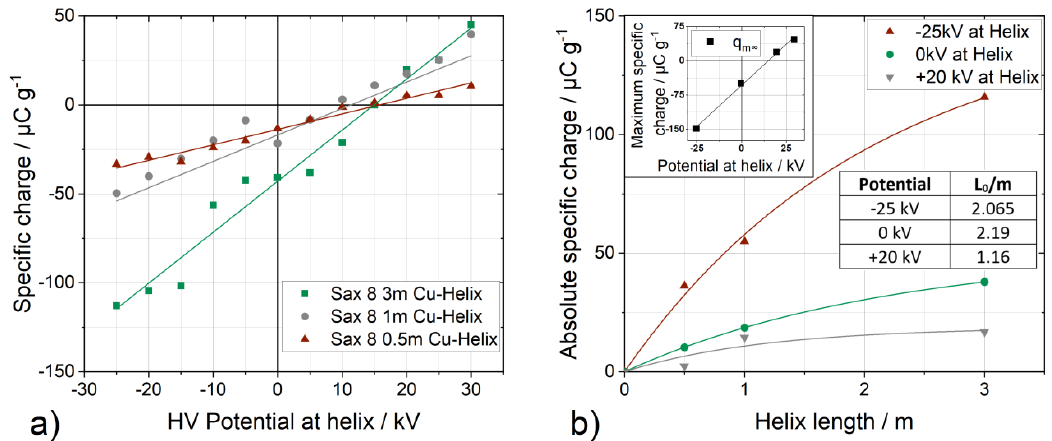
Figure 4. Specific net charge for different lengths and voltages (0.5–3 m) for limestone (Saxolith 8) with ( a ) constant lengths and ( b ) constant voltages.